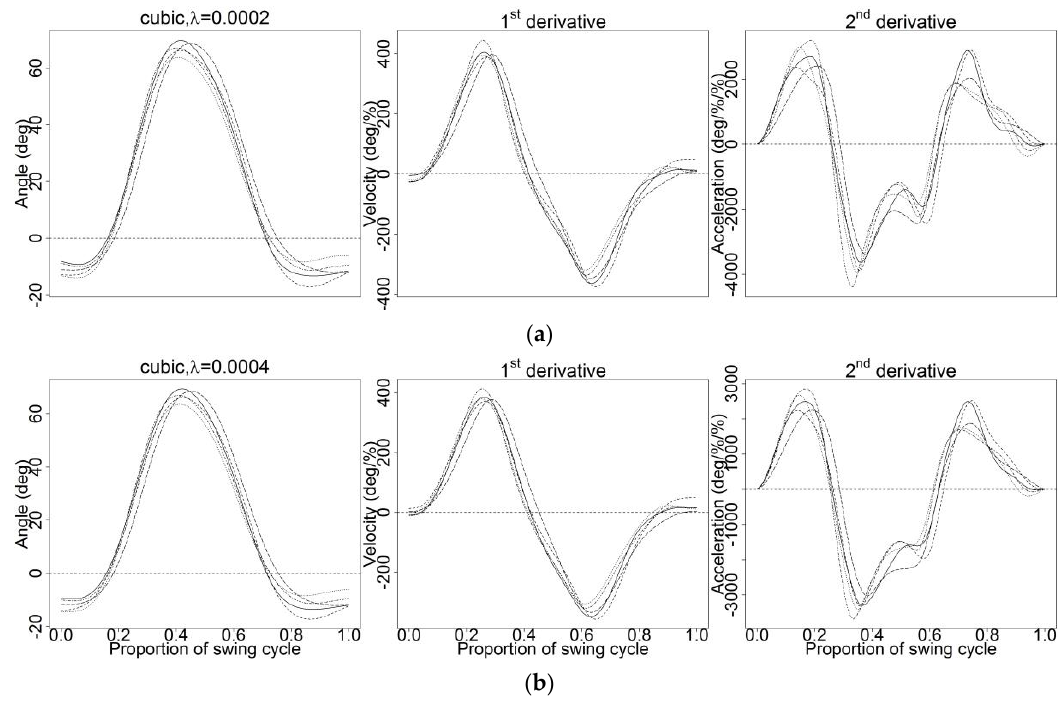
Figure A1. Smoothing using cross-validation (CV) method with ( a ) λ that gives minimum cross-validated error and ( b ) largest value of λ that gives the most regularized model such that error was within one standard error of the minimum using cubic spline basis.